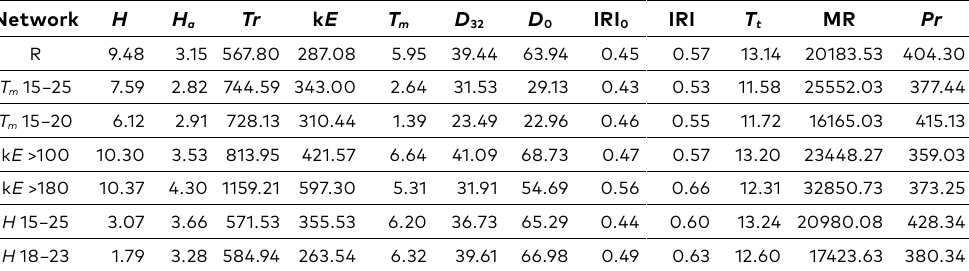
Table 2. The standard deviation of the parameters included in each network